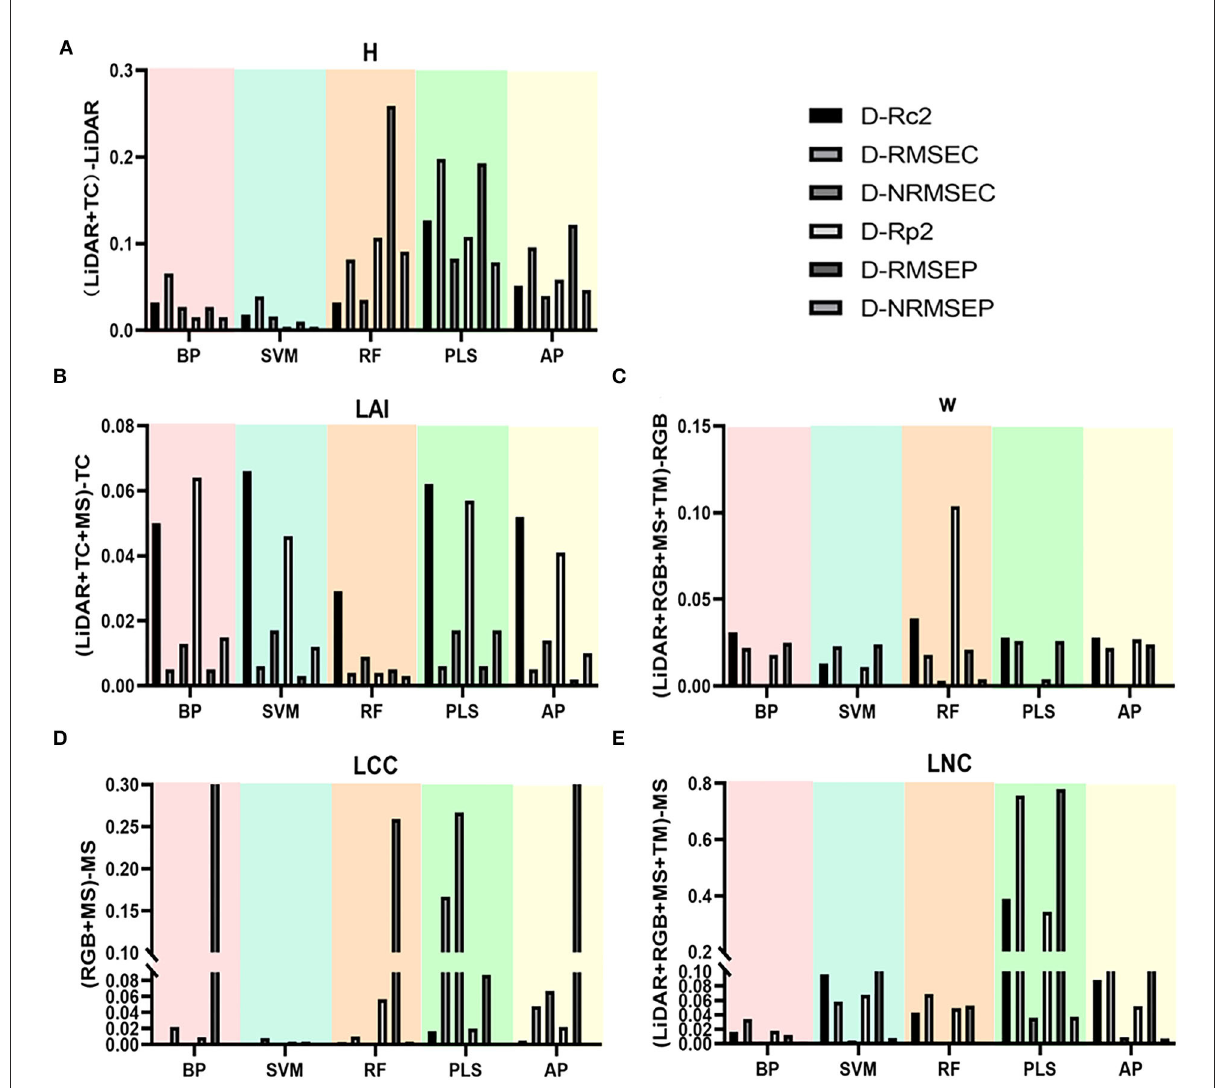
FIGURE10 Evaluation results of single source and multi-source UAV data on tea crown phenotype. (A) H; (B) LAI; (C) W; (D) LCC; (E) LNC.